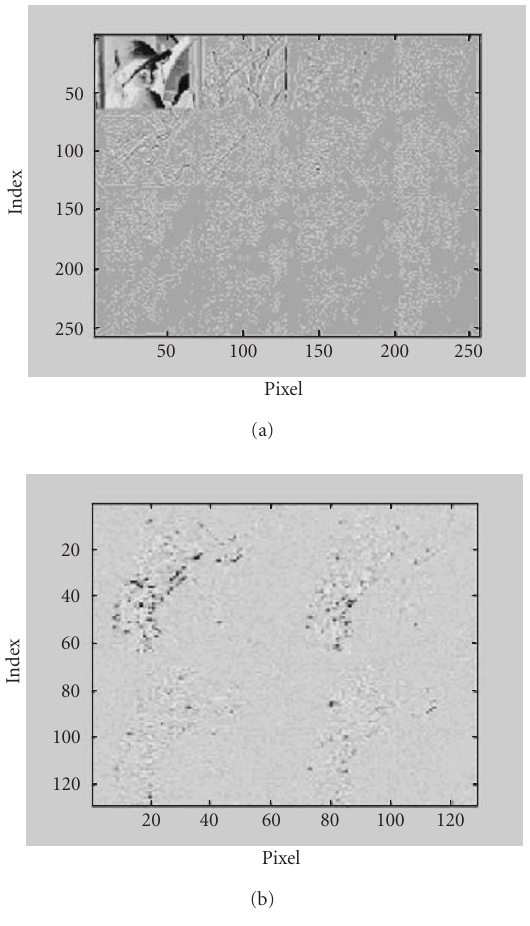
Figure 4: The single-level multiwavelet decomposition of the Lena image: (a) the whole image; (b) the HH subband of the